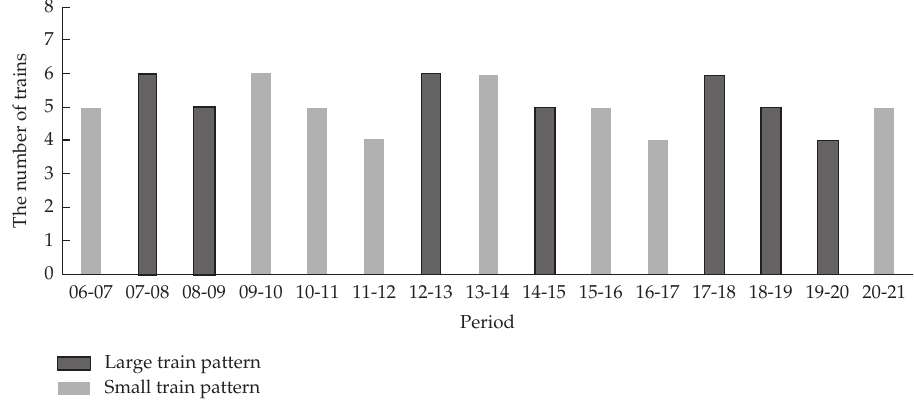
Figure 9: The number of scheduled trains and the train-pattern during each period.